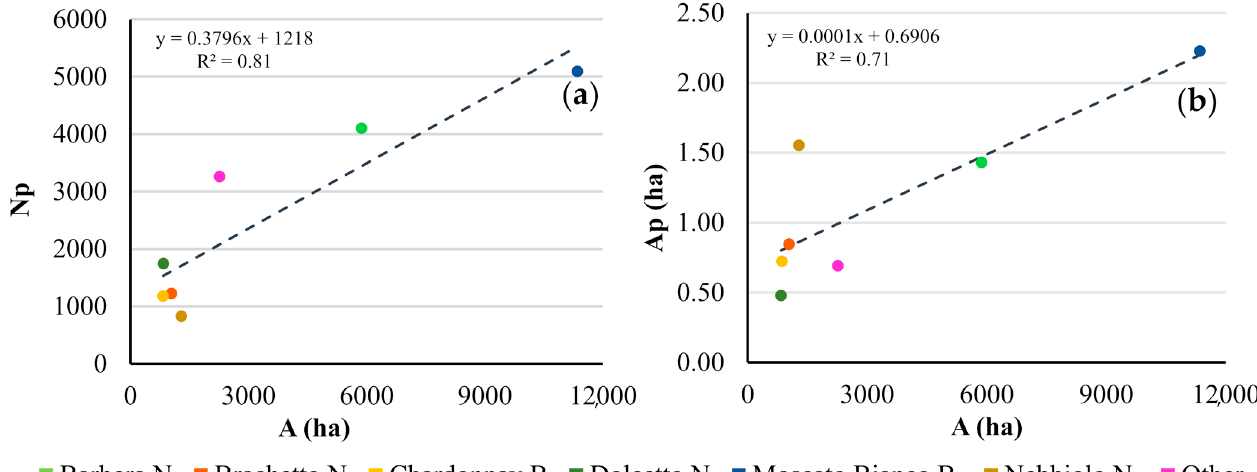
Figure 4. Spatial analysis of grape variety in AOI: ( a ) total area (A—ha) versus the number of parcels (Np) for each grape variety; and ( b ) total area (A—ha) versus the average parcel area size (Ap—ha) for each grape variety.